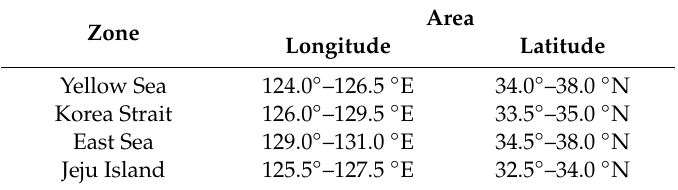
Table 6. Areas for wave energy calculation in the Yellow Sea, Korea Strait, East Sea, and Jeju Island.